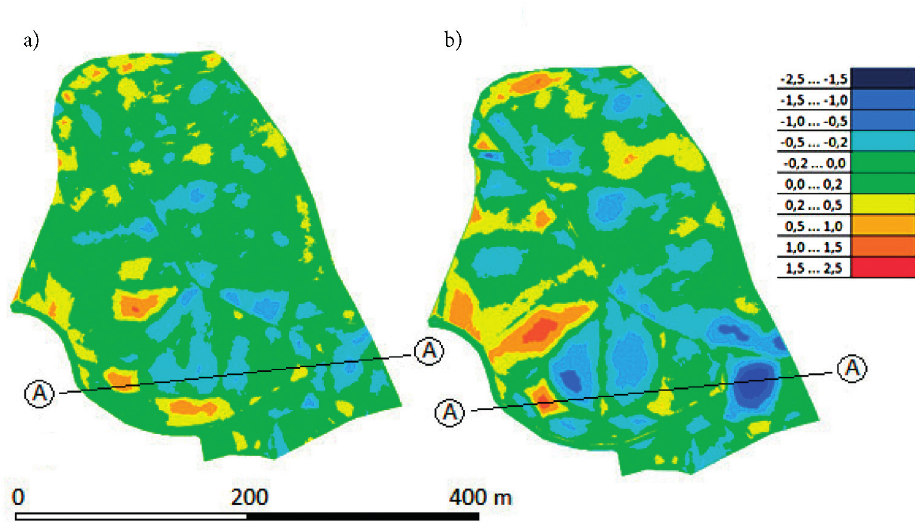
Fig. 8. The comparison models of TLS data and the imitated tacheometric data with the 30 m (left) and 50 m (right) data step Notes: Cooler colours illustrate areas where TLS surface model is above the thinned model. Cross section A-A is explained on Figure 11.